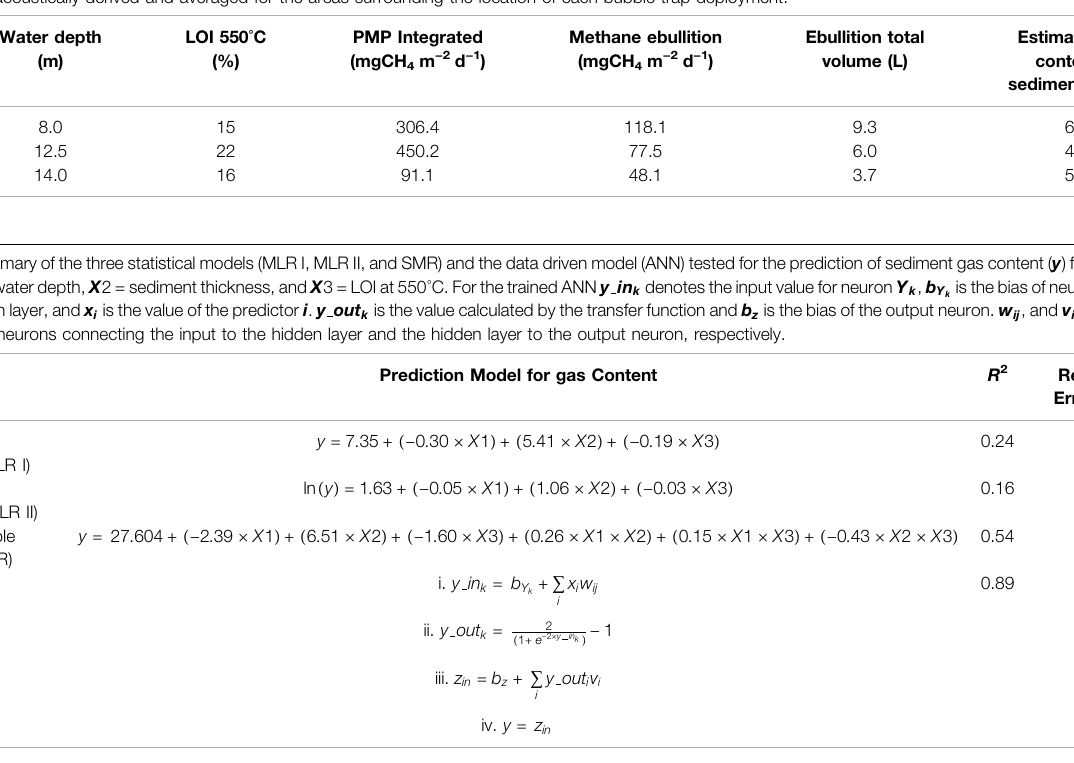
TABLE2| ParametersatthethreemonitoringsitesP1,P2,andP3.Lossonignition(LOI)fromsedimentcoreswereprovidedbySotiri(2020);thePMPwasintegratedforthe top 10 cm sediment layer; methane ebullition was calculated with the measured methane fraction in the gas bubbles of 68.9%; and the estimated gas content in the sediment was acoustically derived and averaged for the areas surrounding the location of each bubble trap deployment.